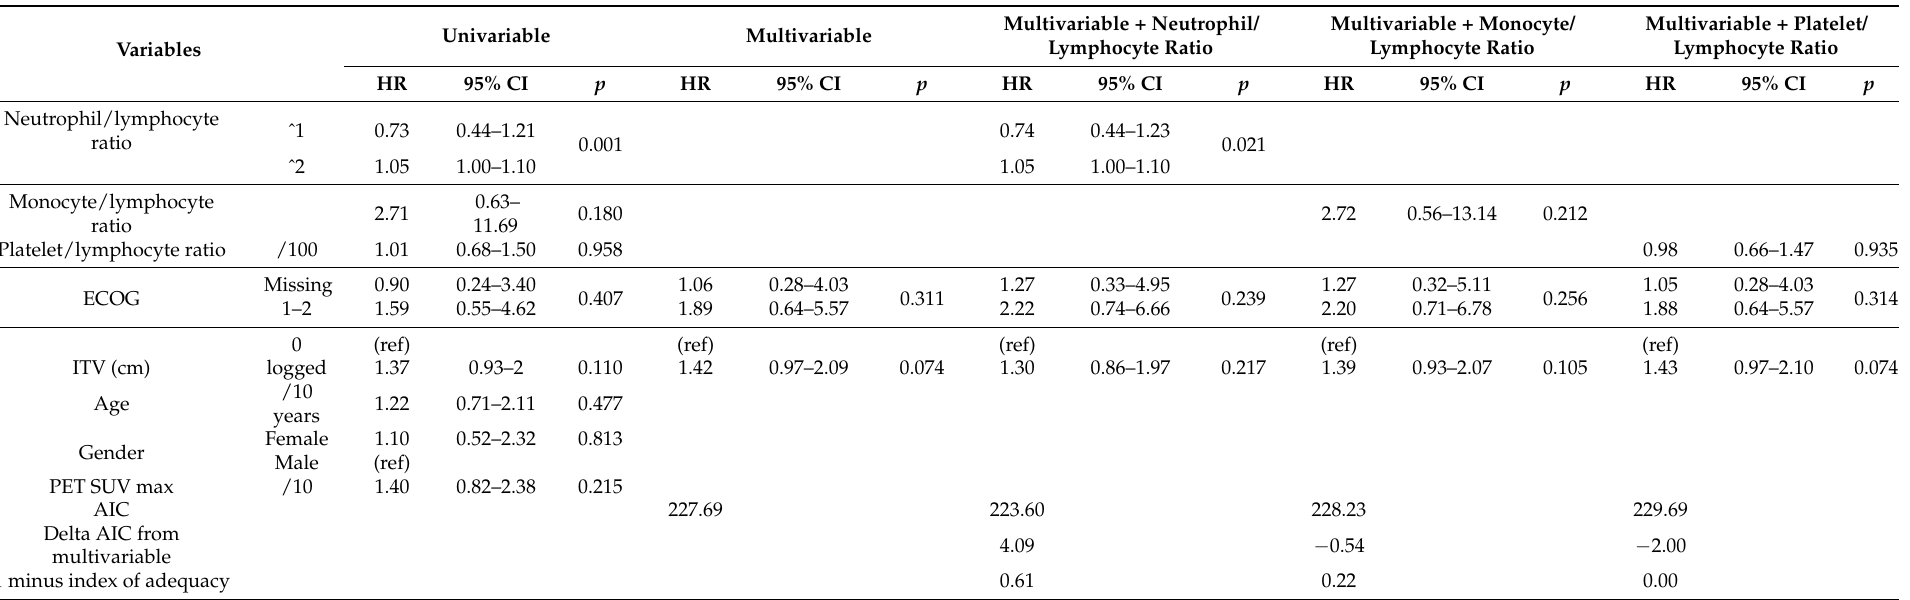
Table 4. Regression model for